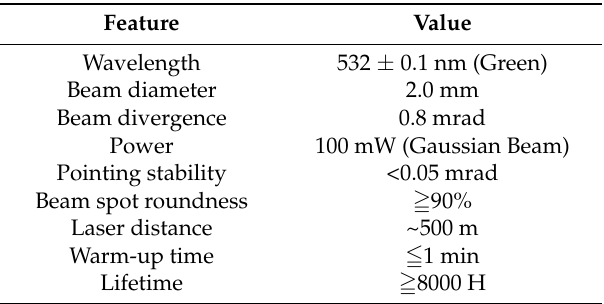
Table 1. Characteristics of the laser